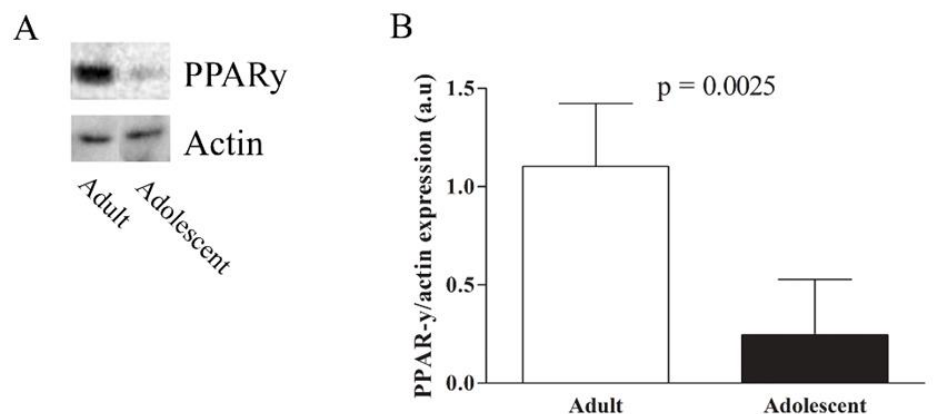
Figure 2. ( A ) Placental protein expression of PPARγ in adults ( n = 7) and adolescents ( n = 6); ( B ) Placental densitometric analysis of PPARγ after normalization by actin. Results are expressed as mean ± SD. p < 0.05 was considered significantly different according to unpaired t test.